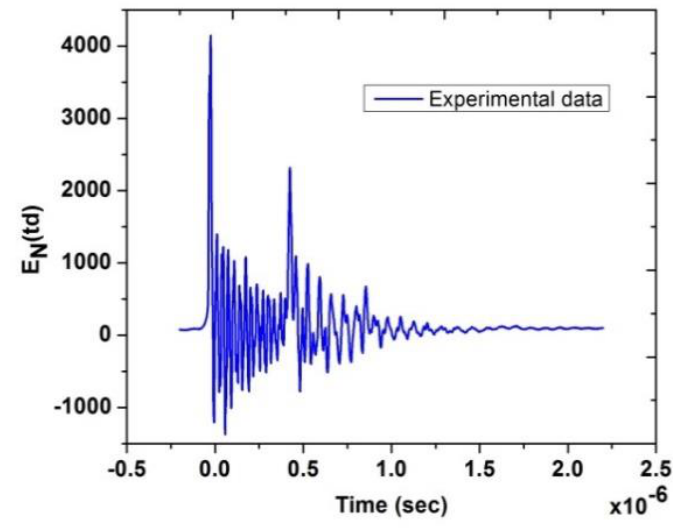
Figure 5. Temporal evolution of experimental E N of Test 2.